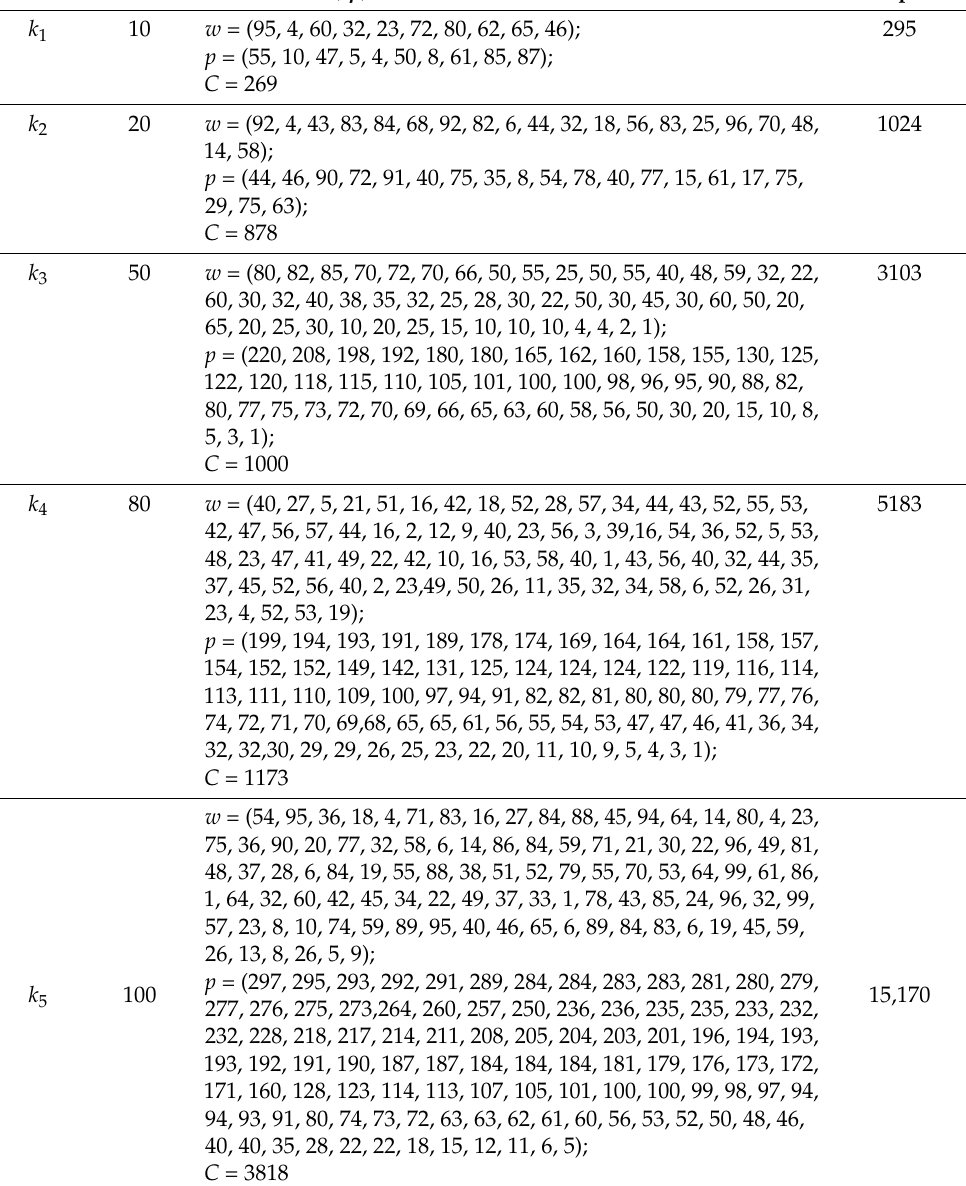
Table 1. Five typical test cases of 0–1 knapsack problems.